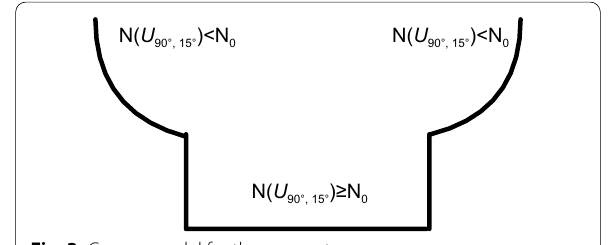
Fig. 3 Groove model for the parameter